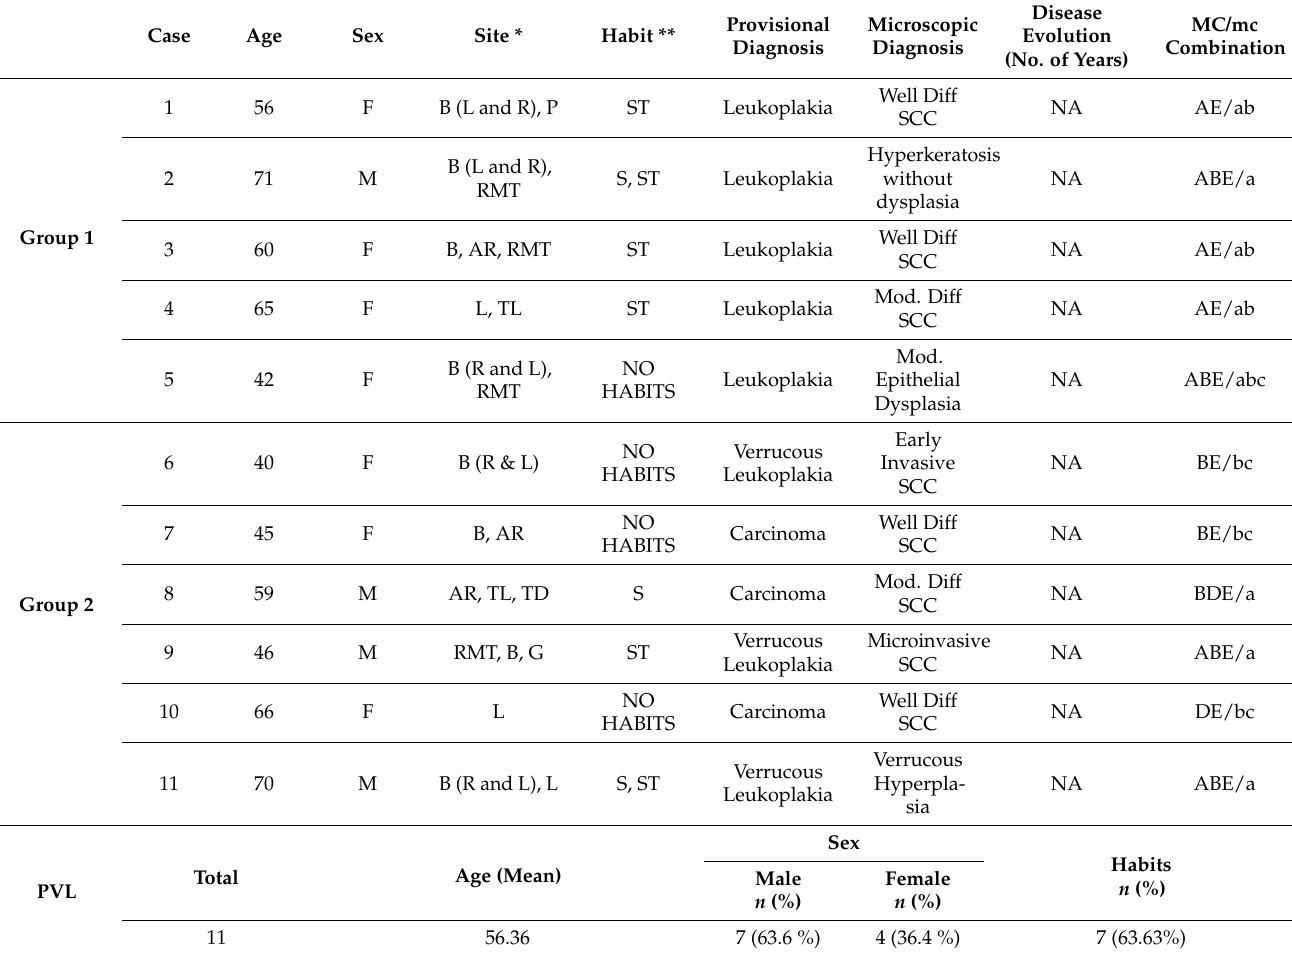
Table 5. Summary of the 11 patients who met the diagnostic criteria proposed by Cerero-Lepiedra et al. [15].